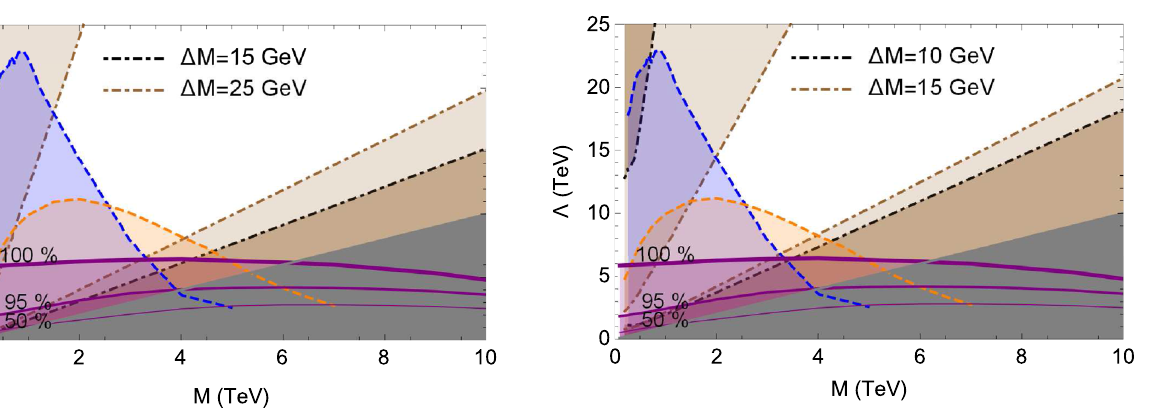
Fig. 3 Bound from (cid:2)ρ in the parameter space ( M ,(cid:5)) for the case of excited lepton doublet with (cid:2) M = 15 GeV, dot-dashed lines (black) and (cid:2) M = 25 GeV, dot-dashed lines (brown). The excluded area with M > (cid:5) is shown in dark grey. Solid (purple) lines indicate the unitarity bound [19] with respectively 100%, 95% and 50% of the events while the dashed (blue and orange) lines are the exclusion limits from LHC run 2 for charged leptons searches with two different final states are also shown for comparison [21,22] ness corresponding to 100%, 95% and 50% event fractions